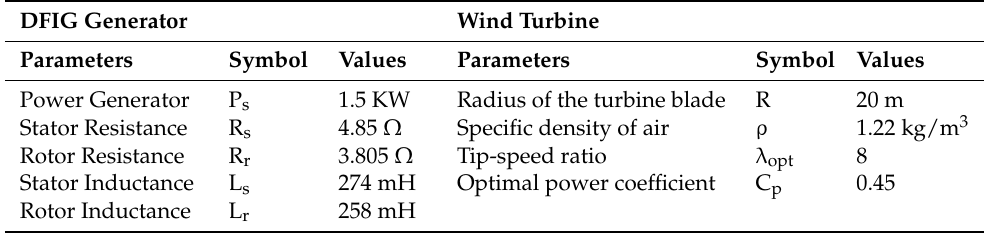
Table A1. The DFIG and wind turbine